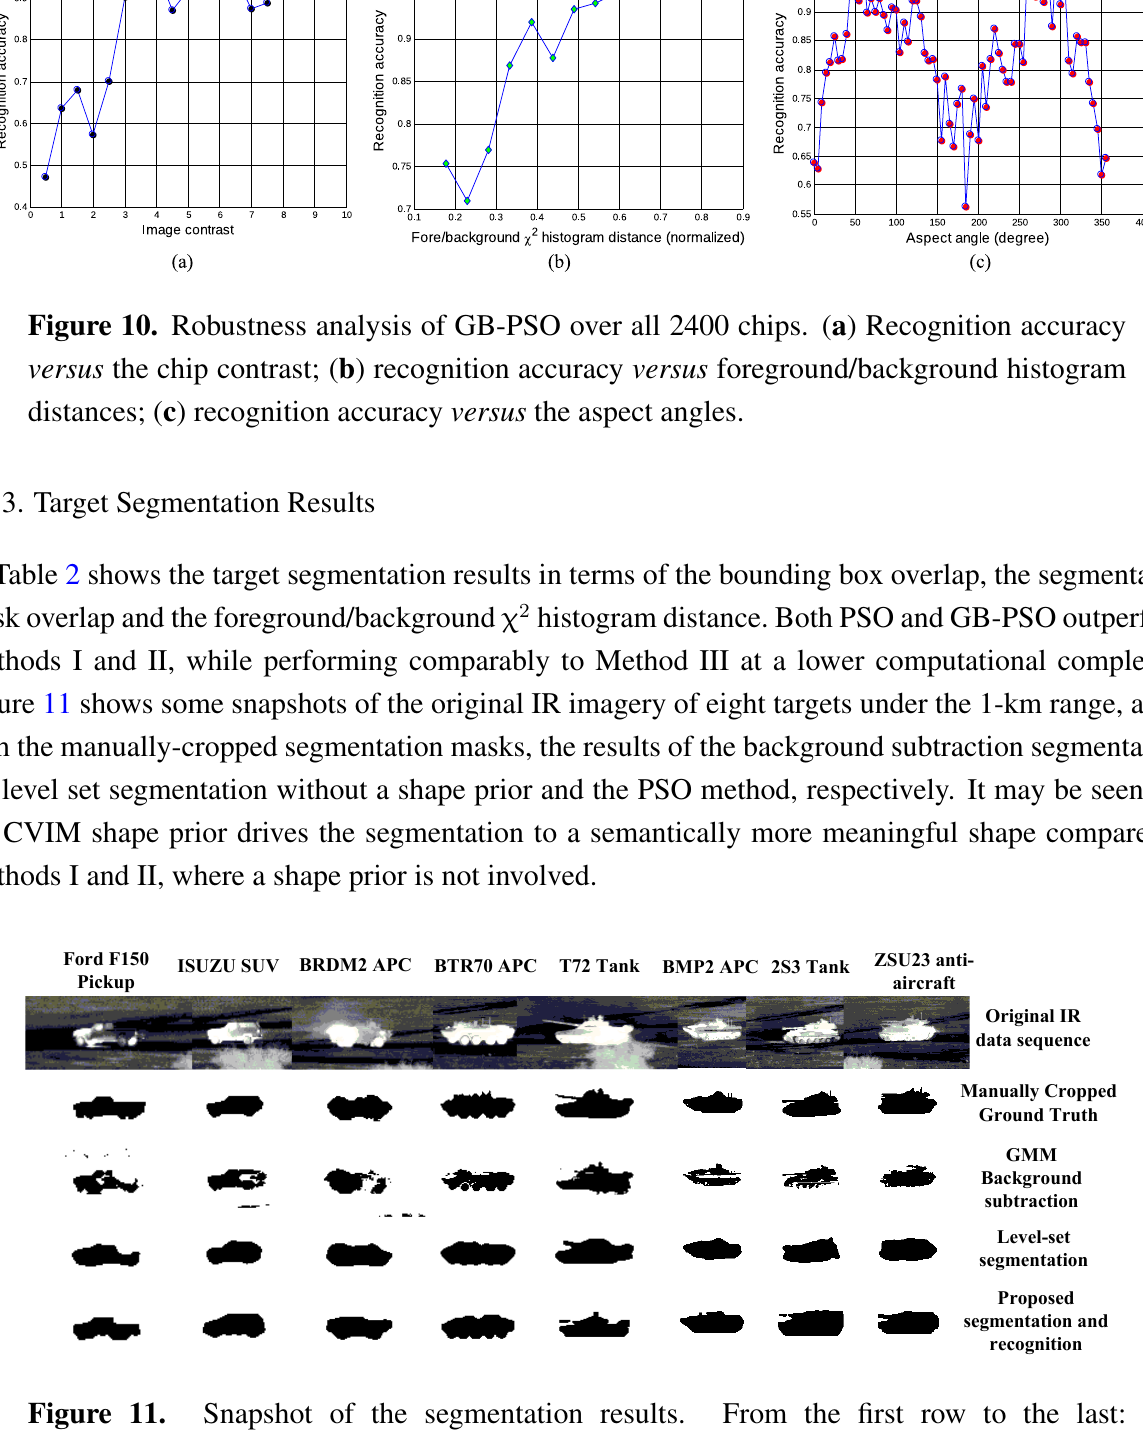
Figure 11. Snapshot of the segmentation results. From the first row to the last: original IR frame, manually-cropped segmentation masks, results of background subtraction segmentation, level set segmentation without shape prior and the final segmentation and recognition results with CVIM shape prior (Method IV) interpolated from the